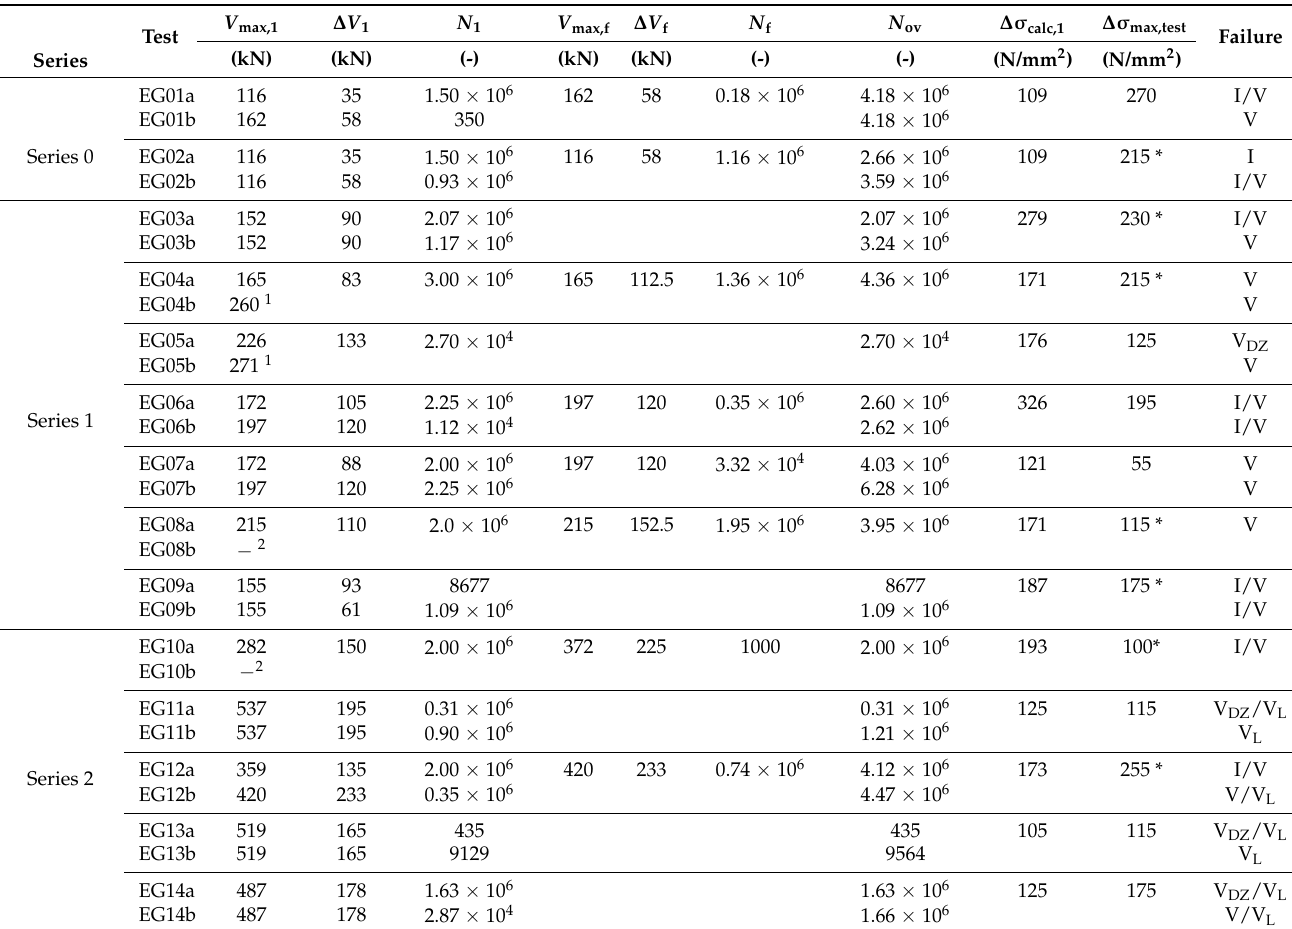
Table 5. Overview of applied load, number of load cycles, and stress